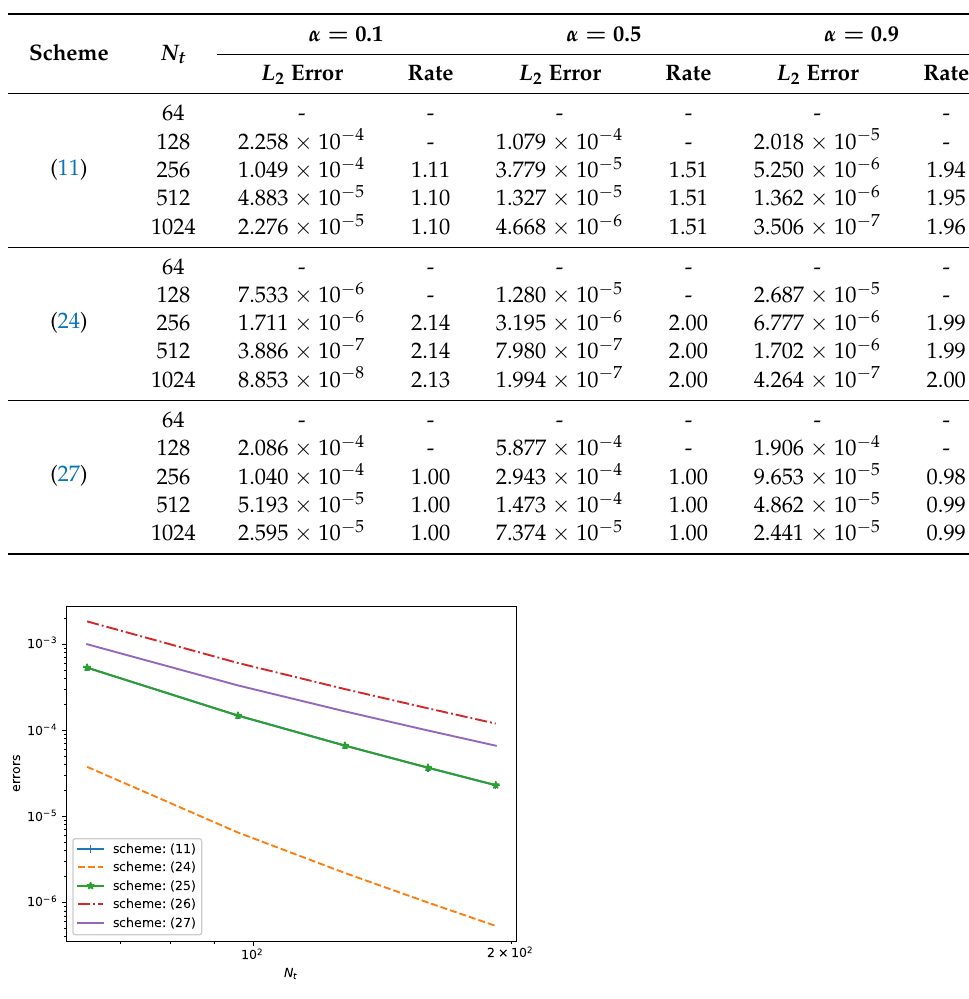
Table 5. The L 2 -norm errors at t = T for non-smooth case in Example 2 with h = ( x r − x l ) /2048.